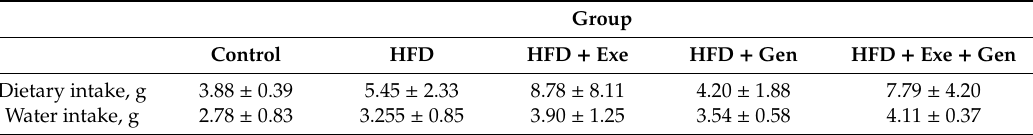
Table 3. Dietary and water